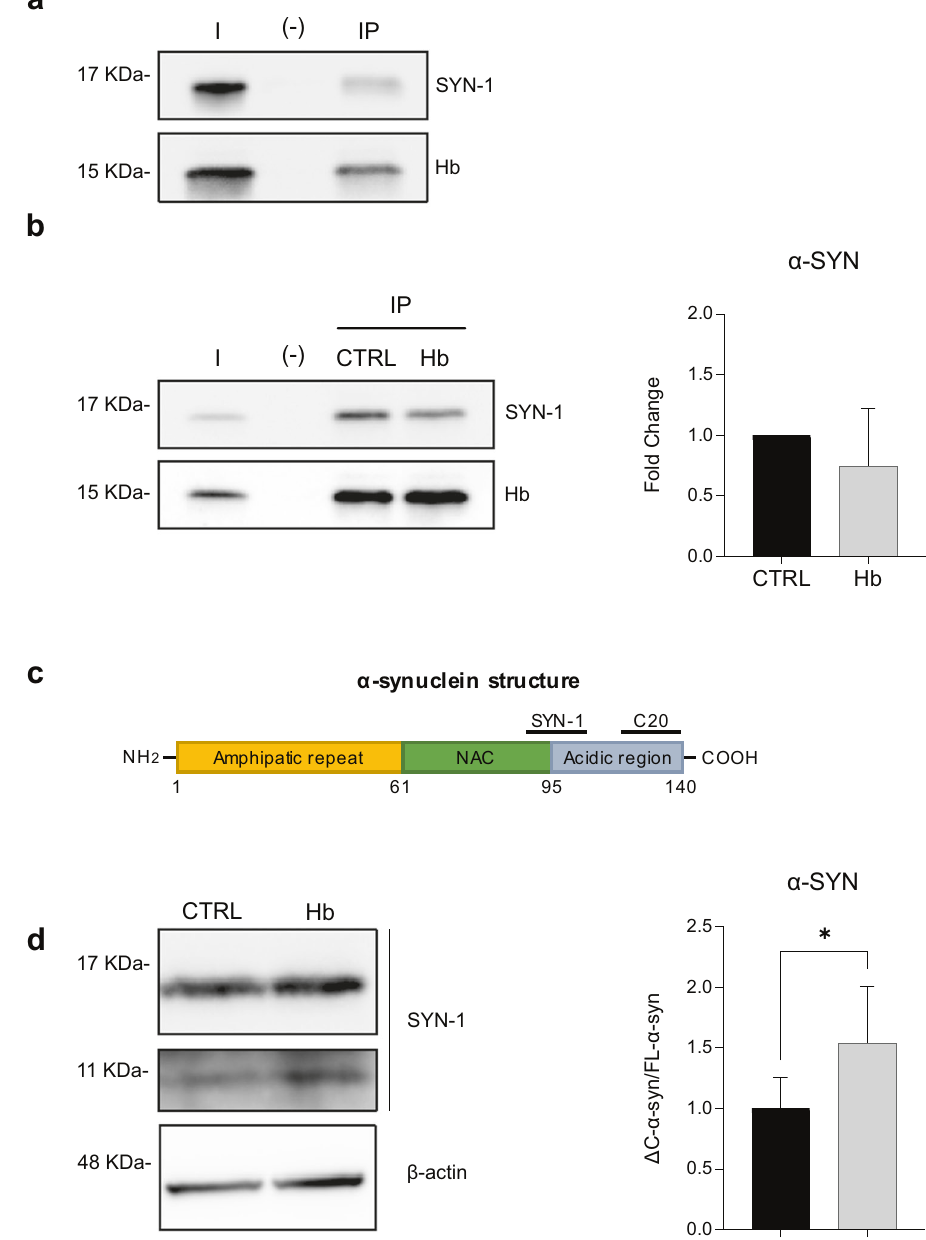
Fig. 3 In vivo investigation of the interplay between α -syn and Hb. Representative immunoblotting with SYN-1 ( a upper membrane) and Hb ( a lower membrane) antibodies of the SN tissue of WT mice ( n = 3) subjected to Hb immunoprecipitation. Representative immunoblotting with SYN-1 ( b upper membrane) and Hb ( b lower membrane) antibodies of the SN tissue of CTRL and Hb mice ( n = 5) subjected to Hb immunoprecipitation. Hb staining ( a and b ) has been used as internal control. Schematic representation of the domain structure of human α -syn protein and epitopes of anti- α -syn antibodies used for the study ( c ). FL- α -syn (17 KDa), Δ C- α -syn (11 KDa) expression in SN of Hb and CTRL mice (n = 8) at 10 months post-injection of ( d left panel) was assessed by western blot. Band intensity was quanti fi ed ( d right panel). I, input; (-), control resin with no antibody; IP, immunoprecipitated samples using anti-Hb antibody (see “ Materials and methods ” ). Data represent means±SEM. Statistical analysis was performed with unpaired t -test with Welch ’ s correction. * p ≤